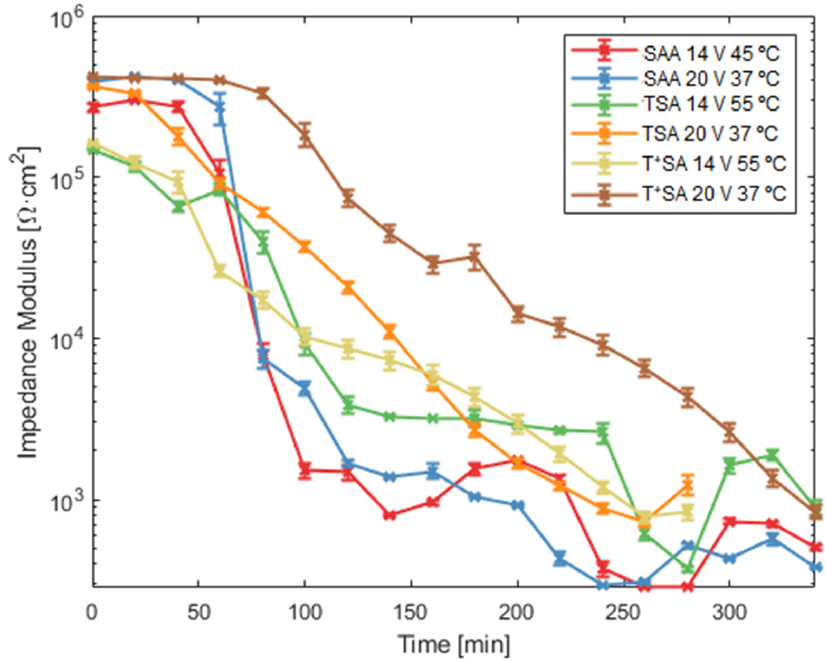
Figure 13. Evolution of the impedance at 0.5 Hz of different with immersion time in an alkalised (pH 10) dilute Harrison’s solution. Error bars represent the addition of stochastic noise and non-stationarities.